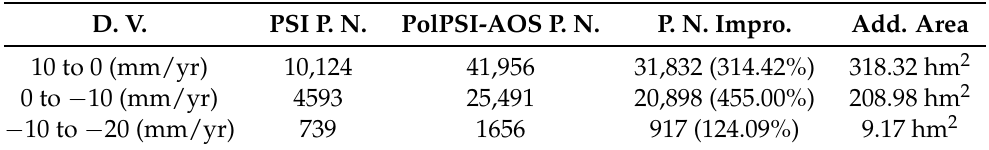
Figure 14. ( a – c ) shows the deformation velocity (in the line-of-sight direction) over XiaoLangDi area derived by PSI (VV), MMSE (VV), and PolPSI-AOS (VV+VH) approach, respectively. The number represents the final number of selected pixels for each approach, and the improvement percentage in the brackets in ( b , c ) is with respect to those derived by the PSI approach. ( d – f ) are a detailed zoom of the white rectangle indicated area (i.e., the dam) in ( a – c ). Table 4. Statistical analysis of PSI and PolPSI-AOS obtained ground deformation results over Xi- aoLangDi